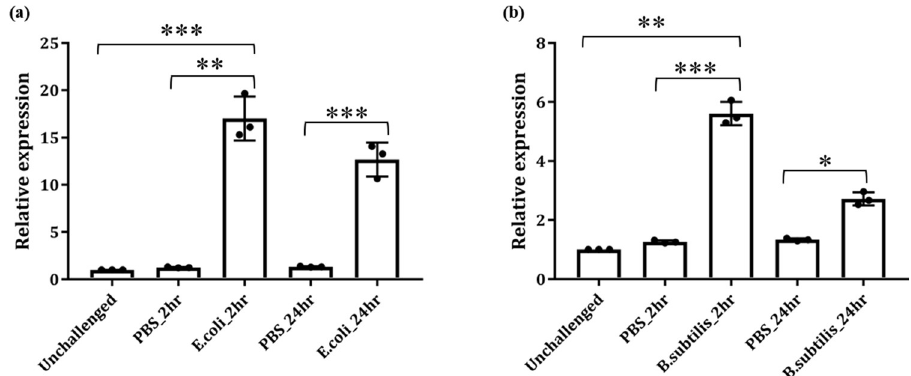
Fig 4. Transcriptional response of AcTrf1a against bacterial challenge. 3–4 days old adult female mosquitoes were injected either with 69 nl of heat-killed bacterial suspension in PBS or PBS alone as a control in mosquito thorax (n = 30–35, N3). After recovery, time-dependent series, hemocyte samples were collected post 2 and 24, hrs of bacterial challenge. (a) Relative transcriptional profiling against E . coli and; (b) Bacillus subtilis showing the immune responsiveness of AcTrf1a to bacterial challenge. Data represented in the figure were from three independent biological replicates, where each dot is equivalent to replicate. Statistical analysis was done using one way ANOVA viz � p < 0.05; �� p < 0.005; and ��� p < 0.0005, ( n = represents the number of mosquitoes pooled for sample collection; N = number of replicates).